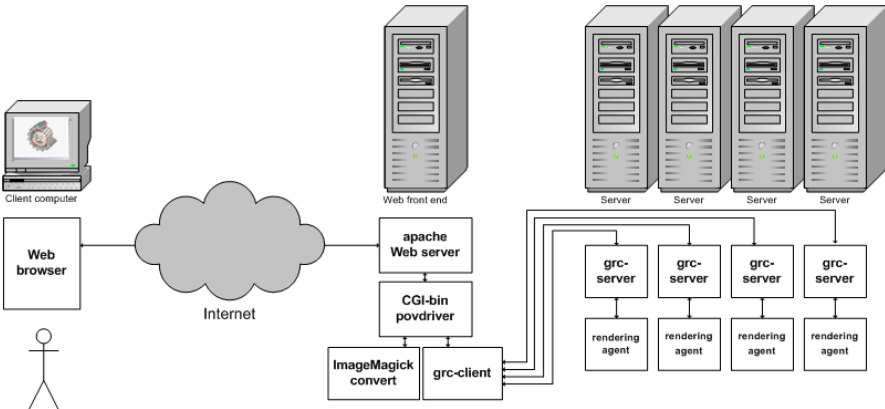
Figure 1. An experimental distributed cluster based on software resilience